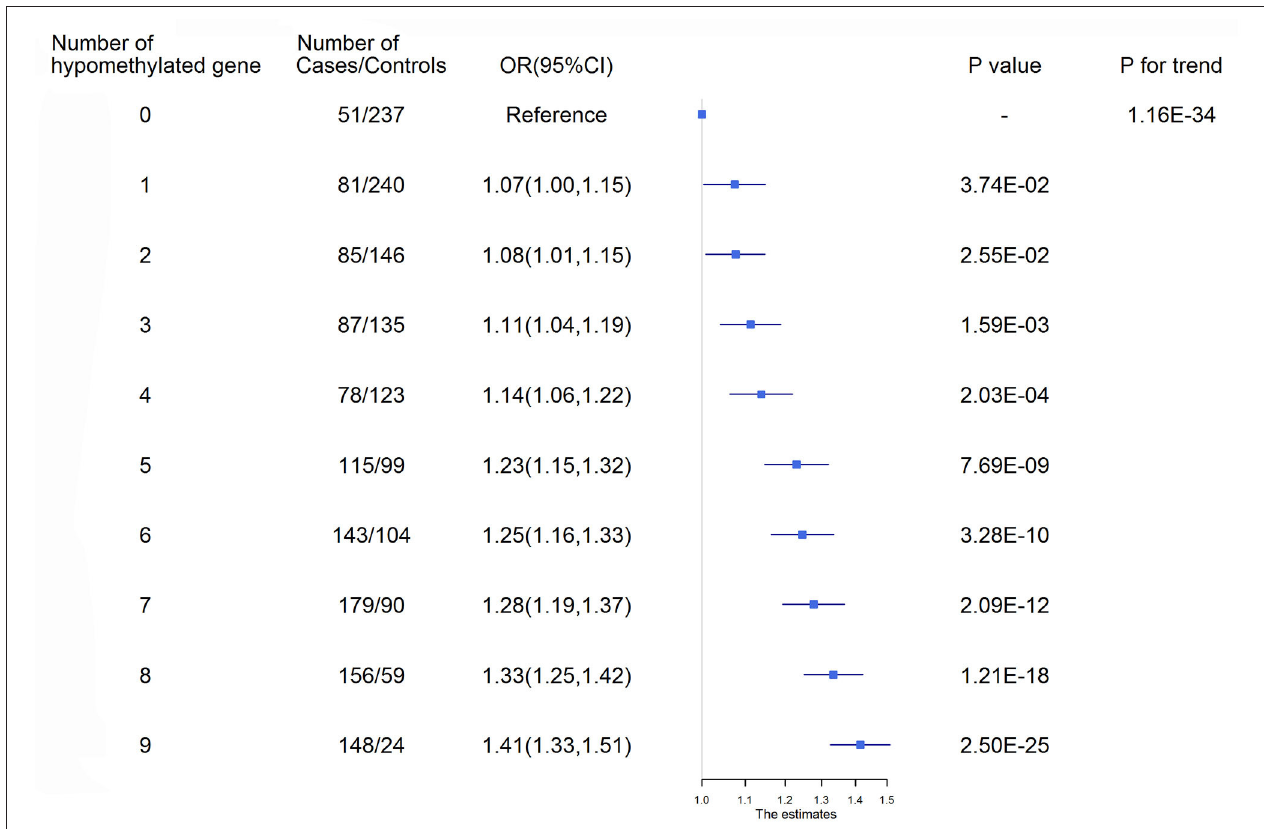
FIGURE 2 | Ischemic stroke risk according to the number of hypomethylated genes. ROC curves were used to obtain the optimal cutoff points for the representative targets of 9 genes, including AMH_3 ( < 3.21%), C17orf82_3 ( < 3.35%), HDAC9_1 ( < 1.88%), IGFBP3_2 ( < 3.90%), LRRC10B_1 ( < 1.09%), PDE3A_3 ( < 2.47%), PRDM6_3 ( < 2.01%), SYT7_1 ( < 1.98%) and TBX2_3 ( < 3.00%), to define hypomethylation. CI, Confidence interval; OR, Odds